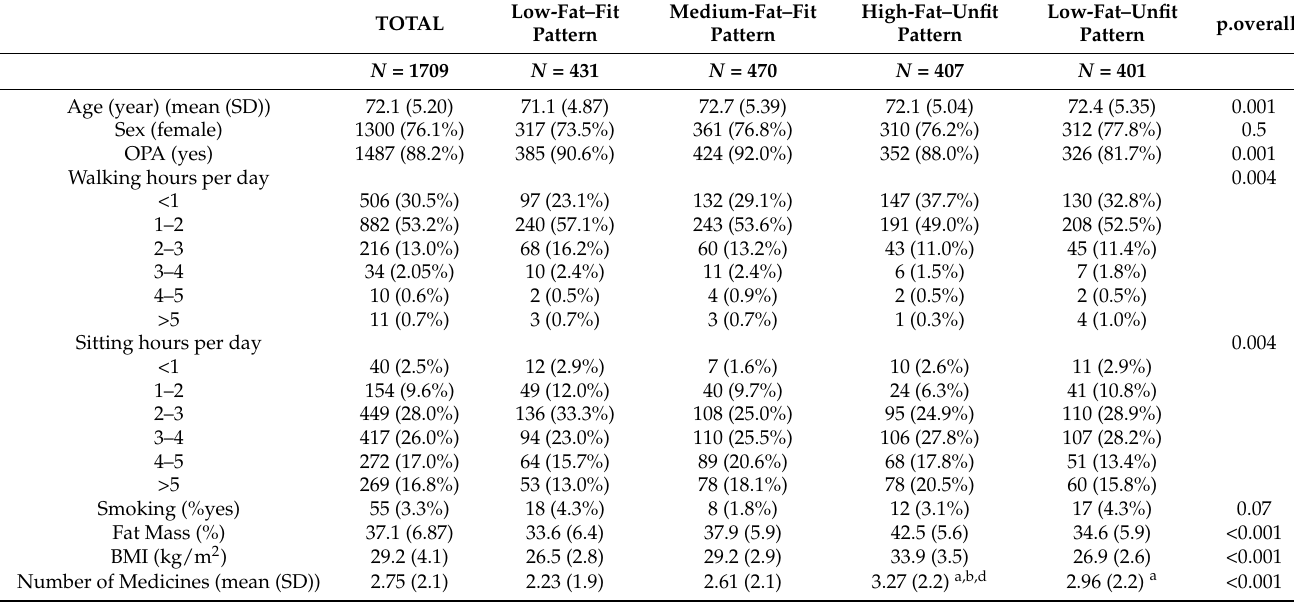
Table 2. Summary of the descriptive characteristics according to the baseline Fat–Fit patterns.